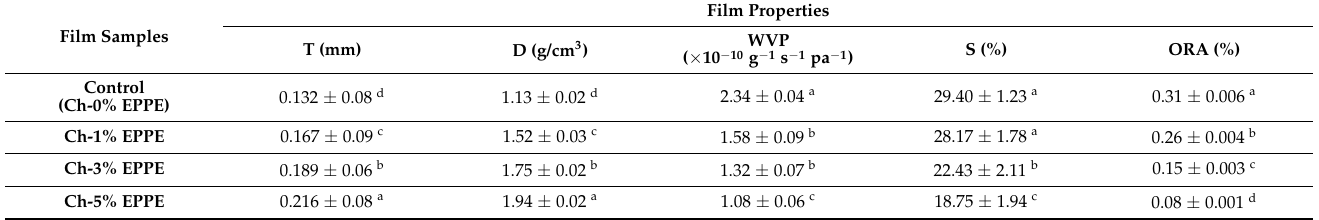
Table 1. Thickness (T), density (D), water vapour permeability (WVP), solubility in water (S), and oil absorption ratio (OAR %) of the chitosan films modified with different percentages of